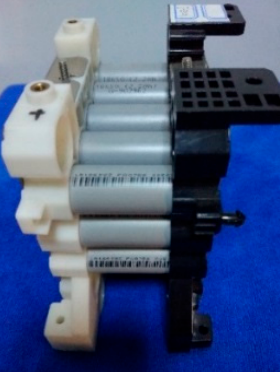
Figure 5. Battery module with 13 cells connected in parallel. Table 1. Specification of the ternary lithium-ion battery (LIB)